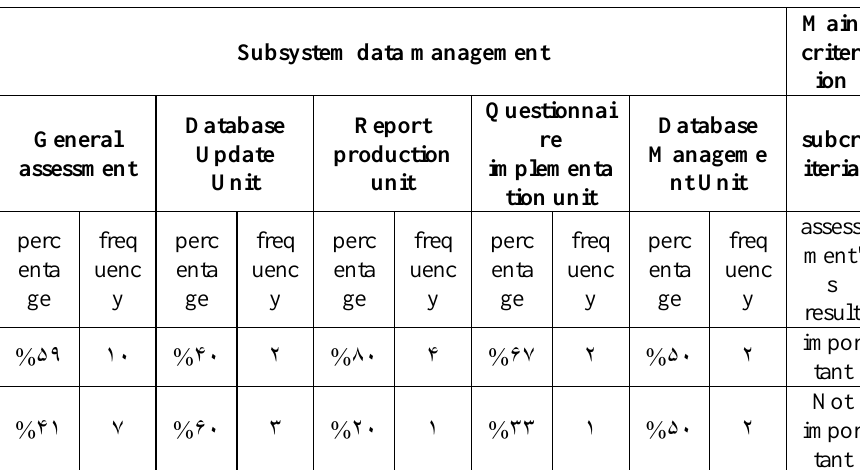
Table 3. Status of the data management